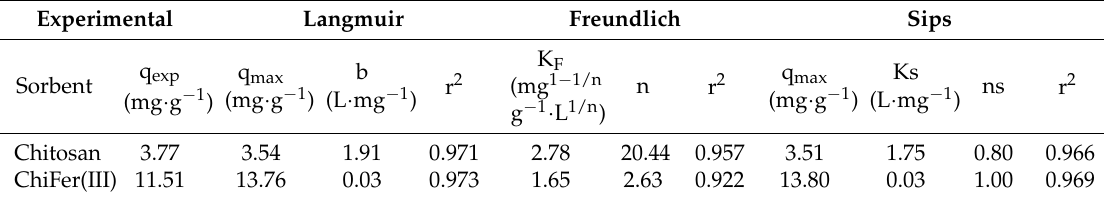
Table 1. Langmuir, Freundlich, and Sips constants of ChiFer(III) and chitosan particles. Experimental Langmuir Freundlich